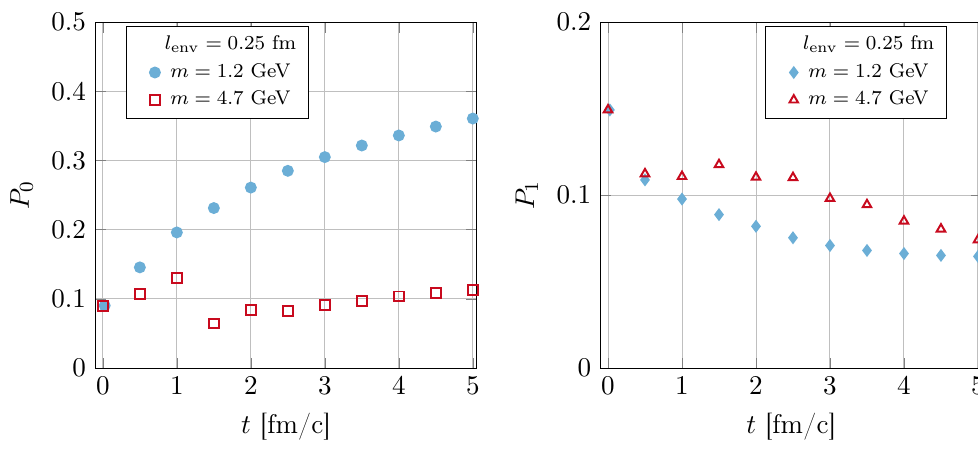
Figure 10 . On the left (right): probability of having the ground (excited) state at time t for di(cid:11)erent masses of the heavy quarks, starting o(cid:11) with an initial density matrix corresponding to a thermal scattering state. For m = 1 : 2 GeV one has (cid:14) = 2 : 5 fm and p = 0 : 69 GeV, whereas (cid:0) (cid:14) = 1 : 26 fm and p = 1 : 37 GeV for m = 4 : 7 GeV. (cid:0) diamonds on the right panel of (cid:12)gure 9). However, when l env < l (see triangles on the 1 right panel of (cid:12)gure 9), the bound-state probabilities evolve in time very similarly to the ones in (cid:12)gure 3 for the lighter quarkonium. In fact, in this case the dissociation process seems slightly more signi(cid:12)cant for the heavier quarkonium than for the lighter